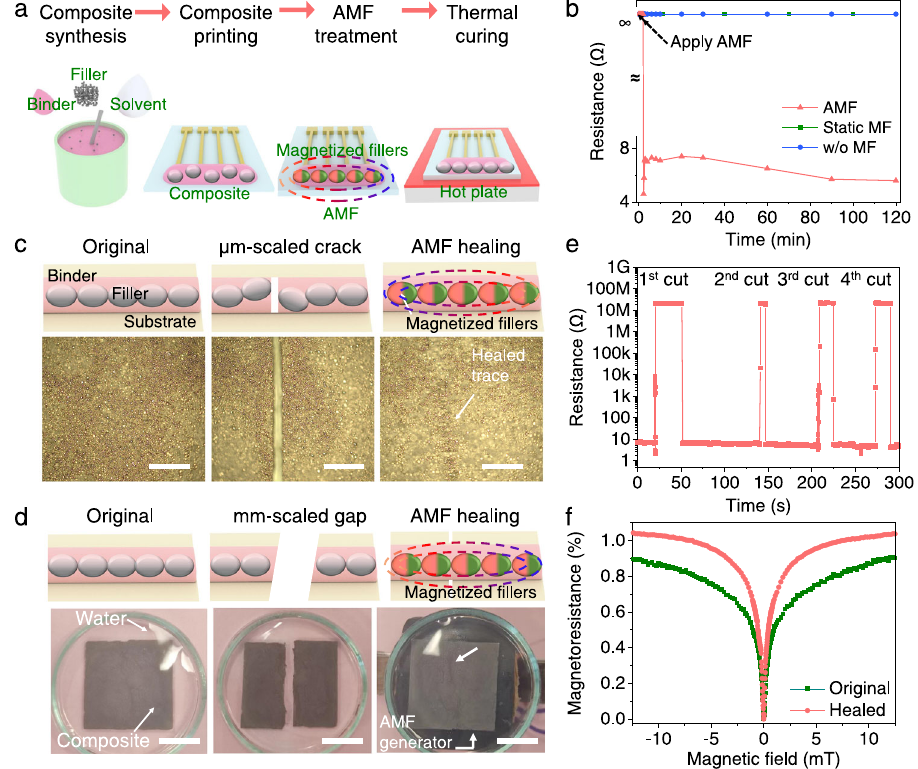
Fig. 1 | Fabrication and self-healing ofmagnetoresistive sensors aided by AMF. a Schematic illustration of fabrication process for magnetoresistive sensors. b Electrical resistance of magnetoresistive composite during curing. c , d Photographs and schematics of the magnetoresistive composite (left to right: original, cutting, healing by 20-s long AMF exposure). Magnetized Ni 81 Fe 19 micro- particles lead to an active healing of percolation networks without the need for manual assembly. In ( c ), the magnetoresistive composite was damaged with micrometer-scaledcracks.In( d ),thecomposite wasdisconnectedwithmillimeter-